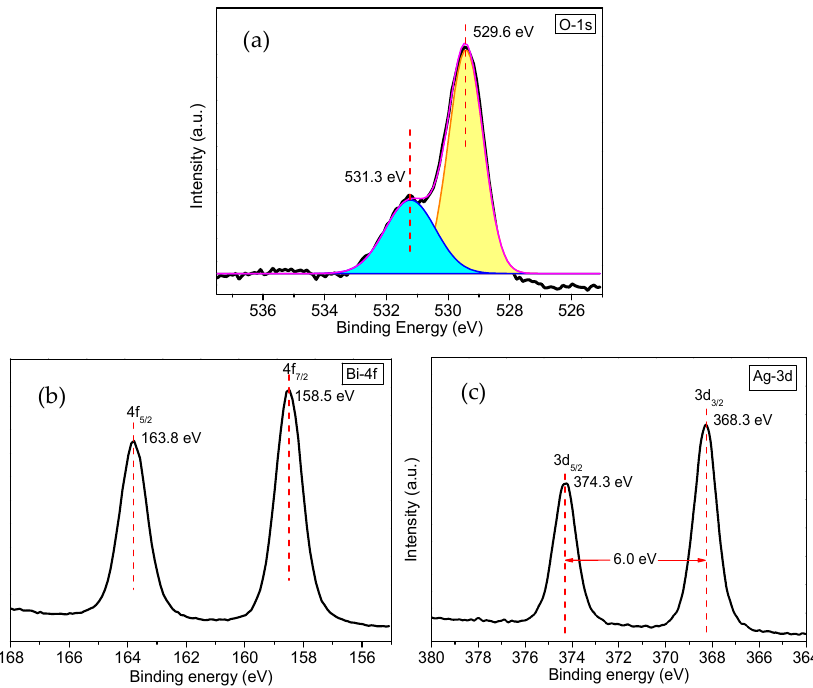
Figure 7. High-resolution XPS spectra of ( a ) O 1s, ( b ) Bi 4f, and ( c ) Ag 3d. The TEM image of Ag NP-loaded Bi 2 O 2 CO 3 / α -Bi 2 O 3 heterojunction microtubes with R c of 6.1% is shown in Figure 8a. As seen from the image, many nanoparticles are evenly dispersed on the surface of microtubes, and strongly anchored. HRTEM was carried out to verify the nanoparticles, as shown in Figure 8b. The lattice structure of nanoparticles anchored on the surface of microtubes is very orderly, and obviously different from that of the microtubes. The measured lattice fringes of 0.245 nm well match the (200) crystallographic planes of metallic Ag, suggesting that Ag NP-loaded Bi 2 O 2 CO 3 / α -Bi 2 O 3 heterojunction microtubes are achieved by this strategy.